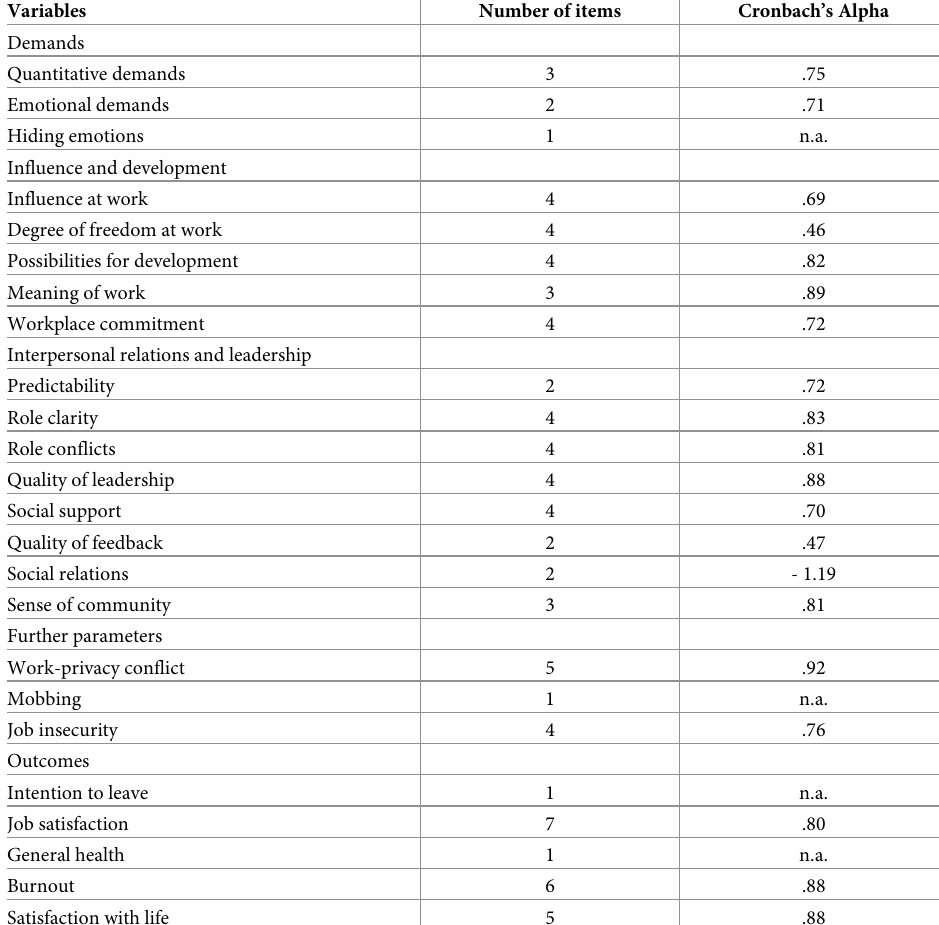
Table 3. Number of items and Cronbach’s alpha of the COSOQ scales.